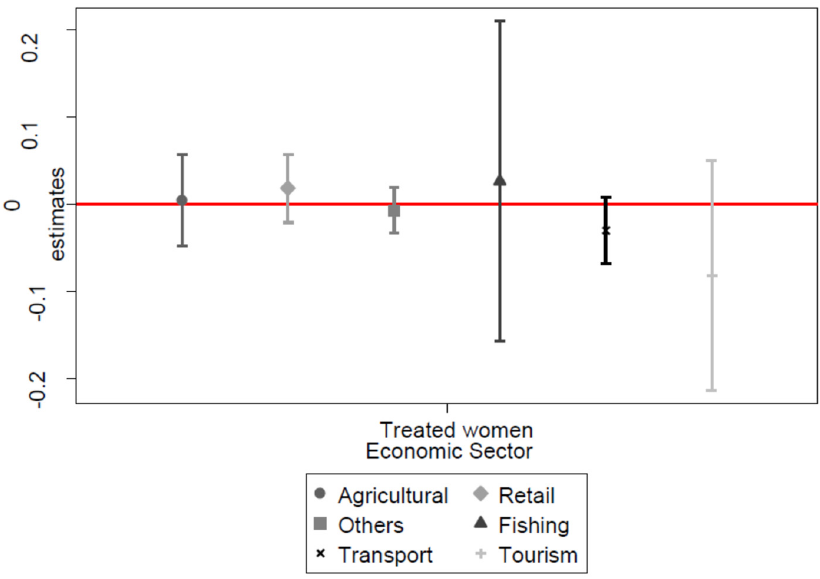
Figure 2. The Effect of CME on Average Loan by Economic Sector (pp).